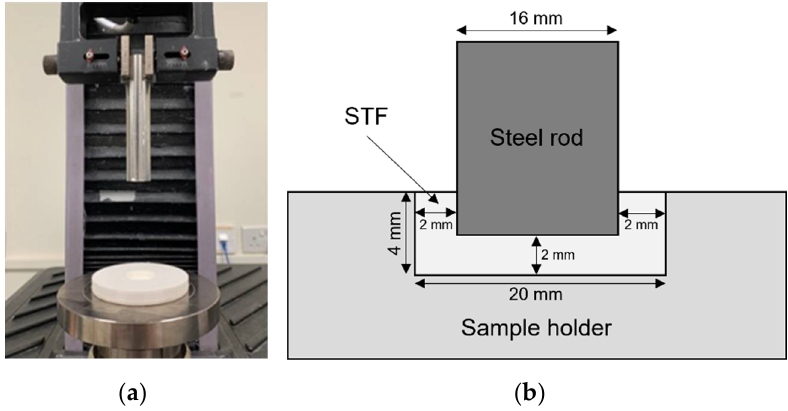
Figure 1. Custom setup for pull-up tests: ( a ) Photo of the setup with a pneumatic grip holding the cylindrical rod at the top and the sample holder attached at the bottom; ( b ) Schematic illustration of the starting position during the pull-up test with all dimensions shown.